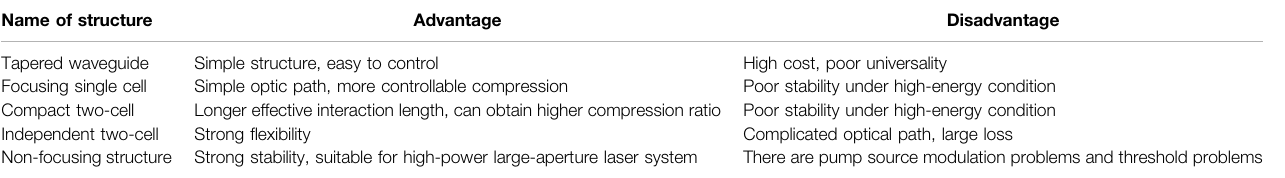
TABLE 3 | Summary of the advantages and disadvantages of each structure.